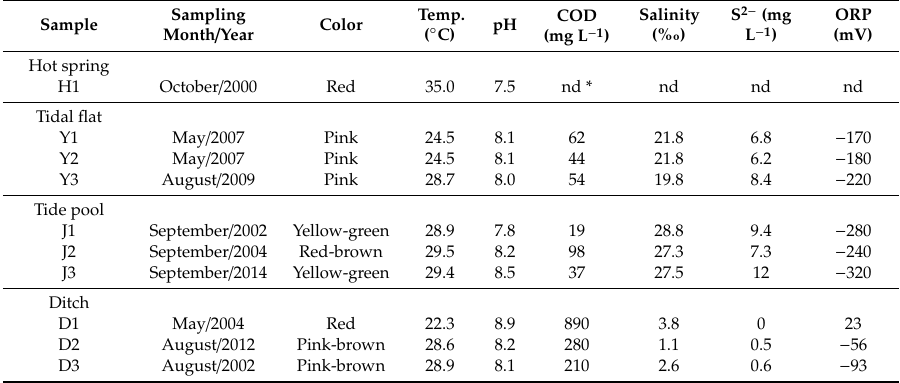
Table 1. Physicochemical characteristics of colored bloom / mat samples